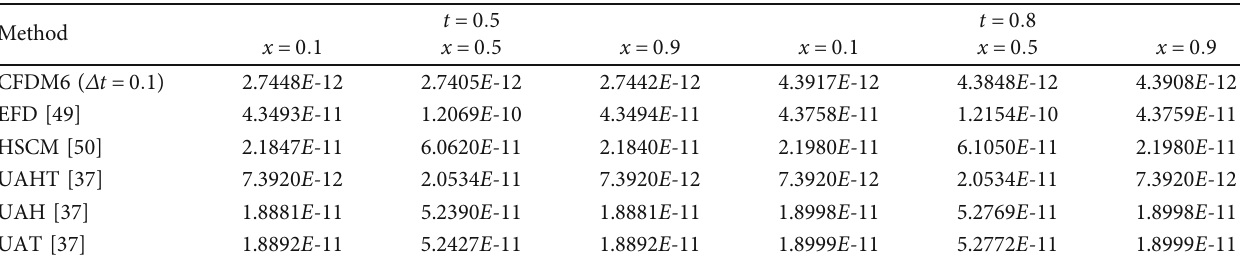
Table 7: Comparison of absolute error of Example 5 with β = 0 : 1 , γ = 0 : 001 , η = 0 : 0001 , δ = 2 , h = 0 : 1 , and Δ t = 0 : 0001 .